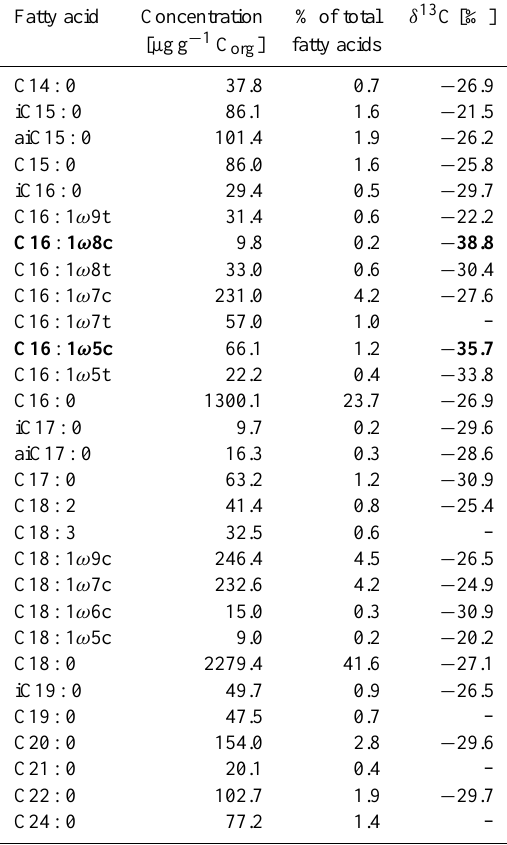
Table 1. Concentrations, relative abundances and δ 13 C values of in- dividual fatty acids (analysed as methyl ester derivatives) at 100m water depth of the Gotland Deep. Fatty acids specific for methan- otrophic bacteria are given in bold